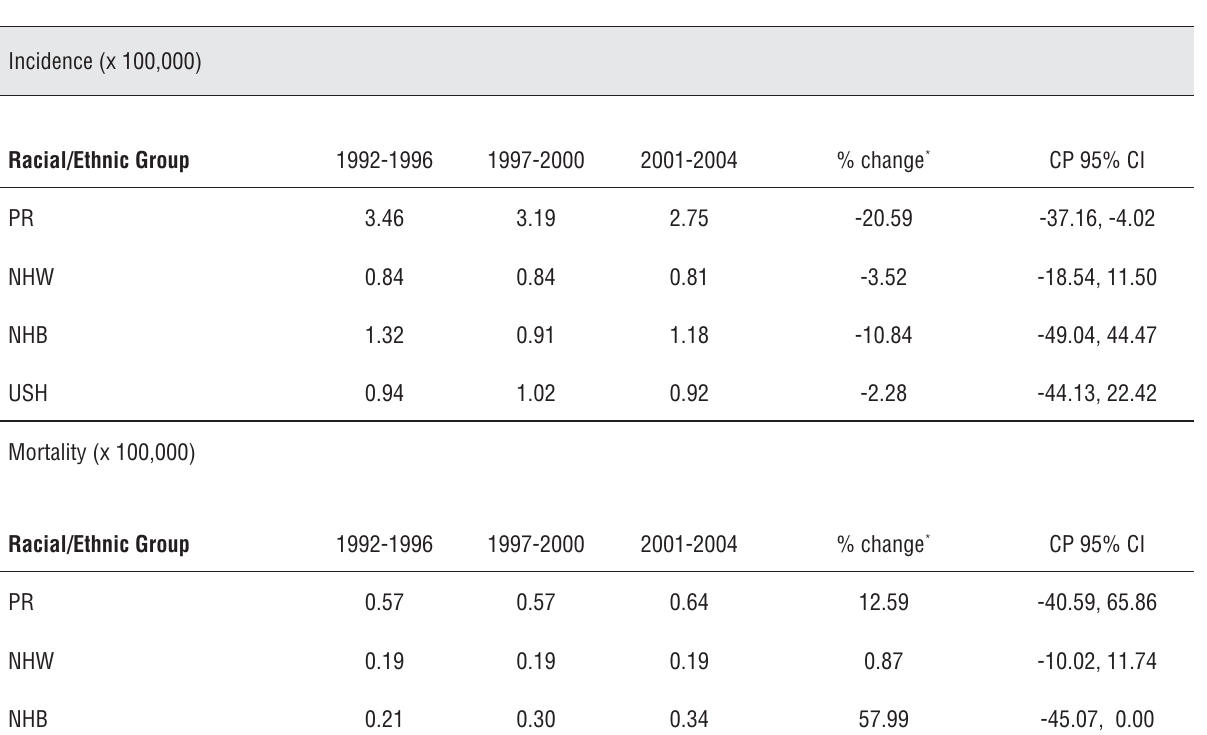
Table 1 - Incidence and mortality for penile cancer among men in PR and racial/ethnic groups in the US: 1992-1996, 1997- 2000, and